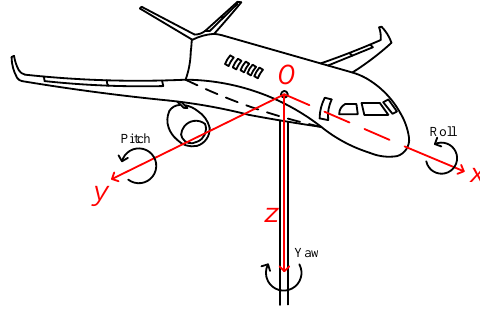
Figure 1. 3-DOF wind tunnel virtual flight test.